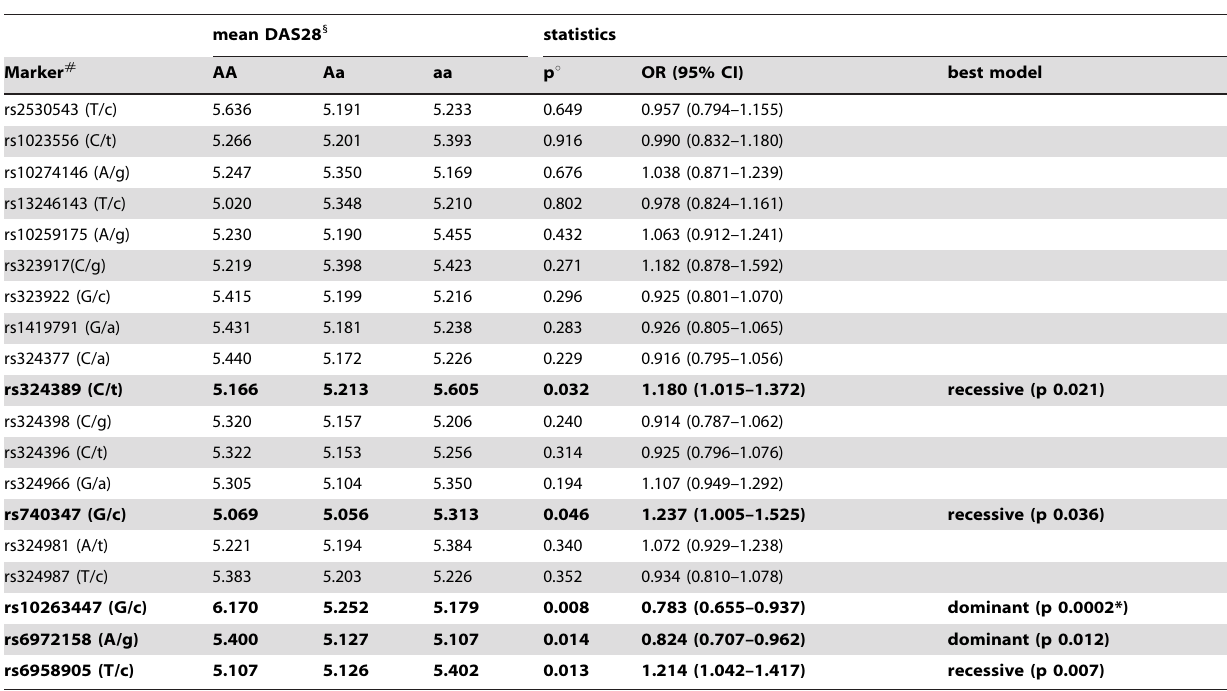
Table 2. Association between NPSR1 SNPs and DAS28 in rheumatoid arthritis